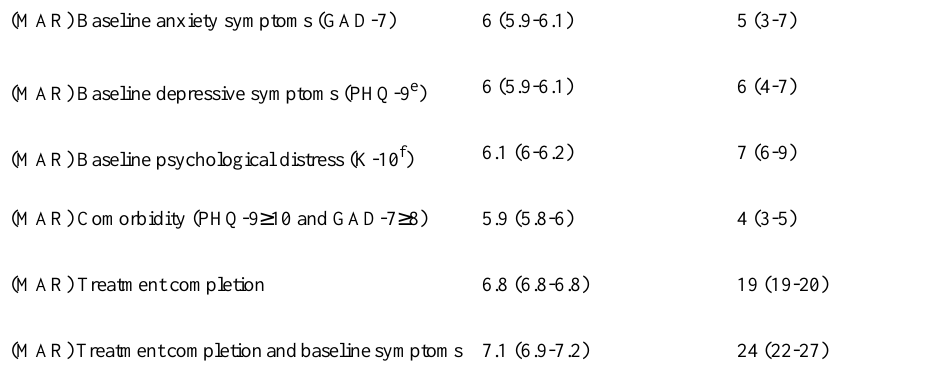
Models adjusted for predictors that form nonignorable missing cases mechanisms (missingness and GAD-7 d outcome moderators)